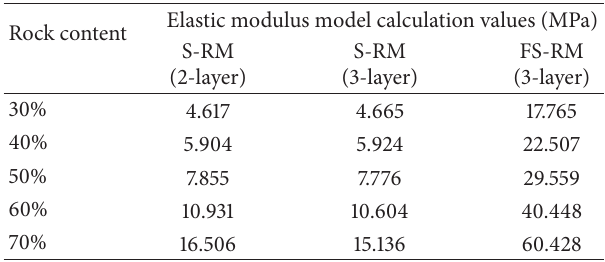
Table 3: Elastic modulus model calculation values of S-RM and FS-